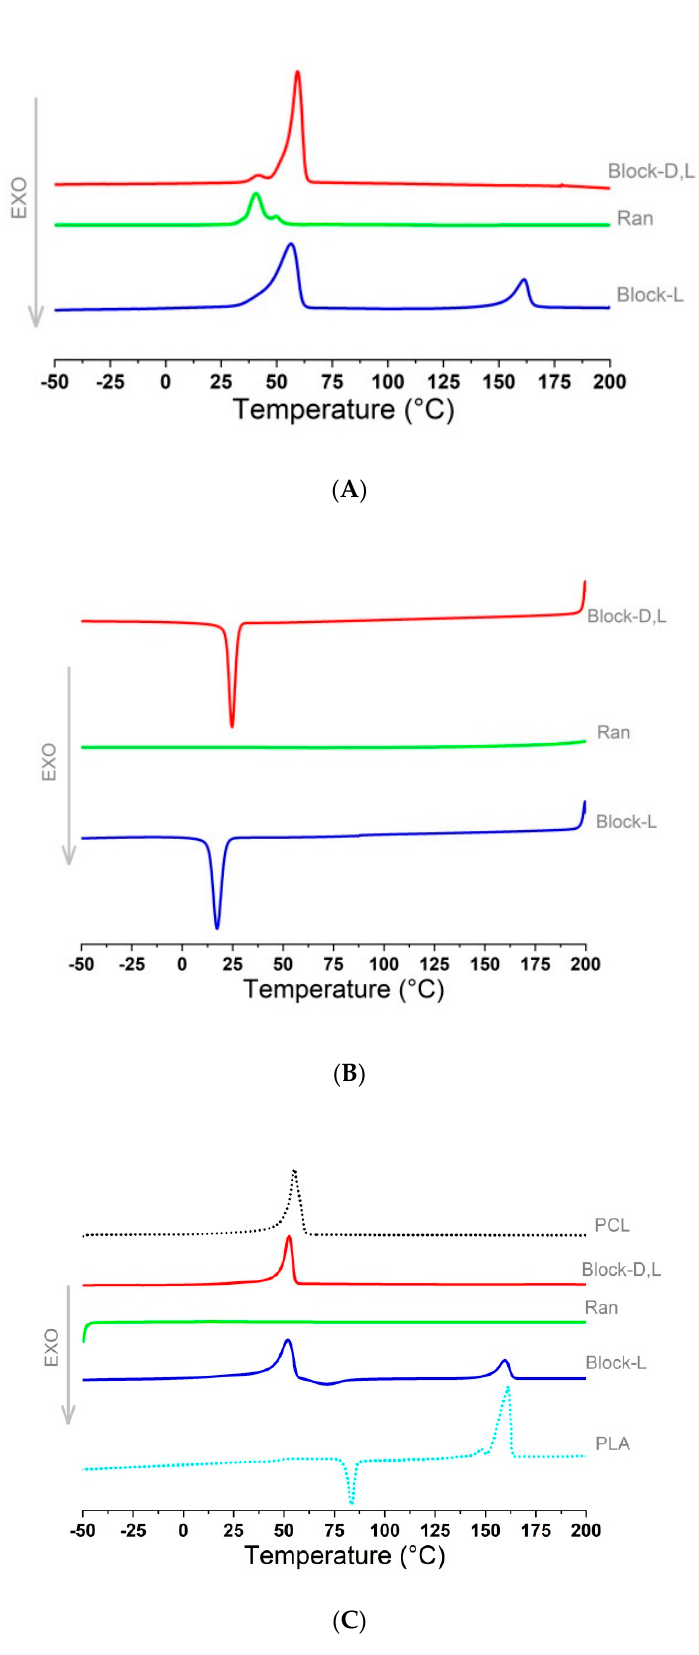
Figure 5. Differential scanning calorimetry (DSC) curves of the analyzed samples. ( A ) First heating; ( B ) Cooling from the melt; ( C ) Second heating.